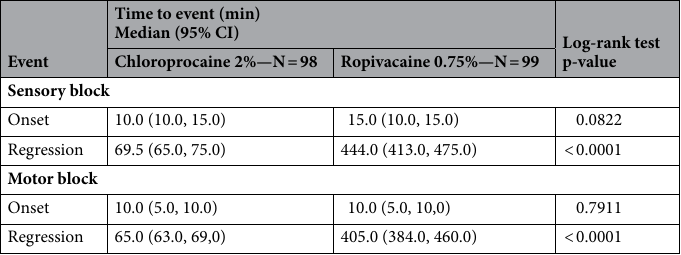
Table 4. Time to onset and regression of sensory block and motor block (min).